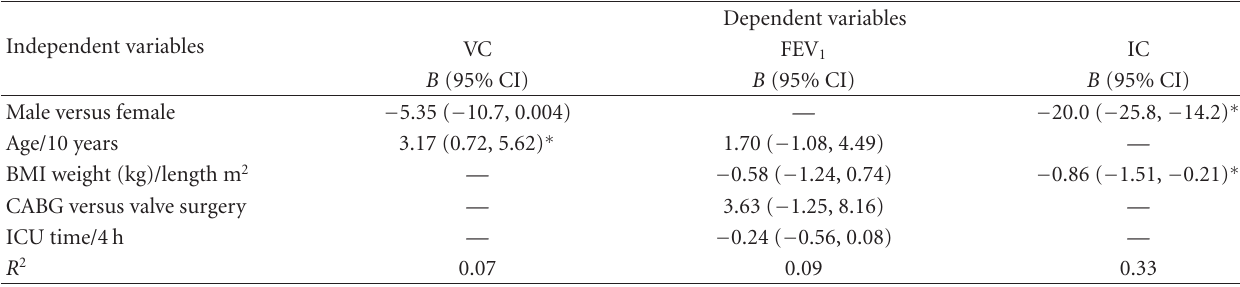
Table 3: The variables associated with postoperative lung volumes (expressed as percent of predicted values), ( n = 107). Multivariate analyses. Independent